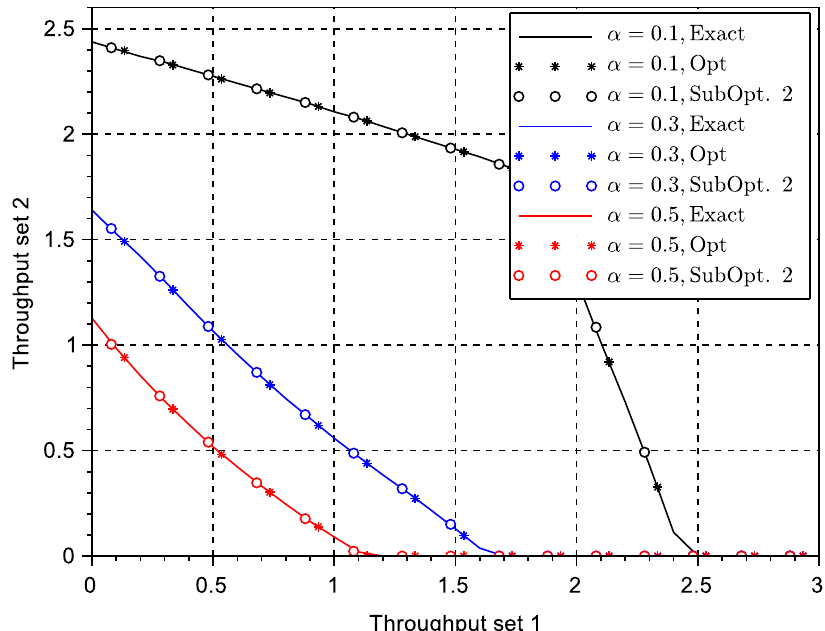
Figure 5. Throughput region of a multi-packet reception (MPR) system with two subsets of terminals: J 1 = J 2 = 3 using the general reception model with different values of the reception parameter α .